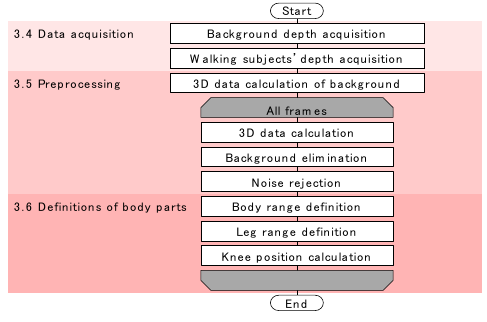
Figure 2. Flow of our system.